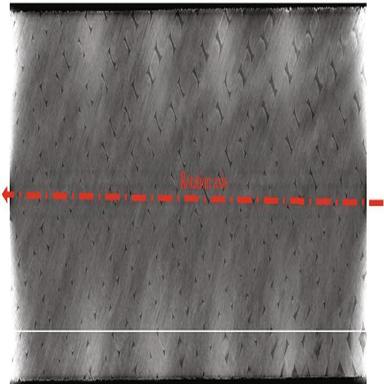
Slice of µCT scan (45x15 mm2 ). Intensity drop along the axial direction at each circular orbit transition.